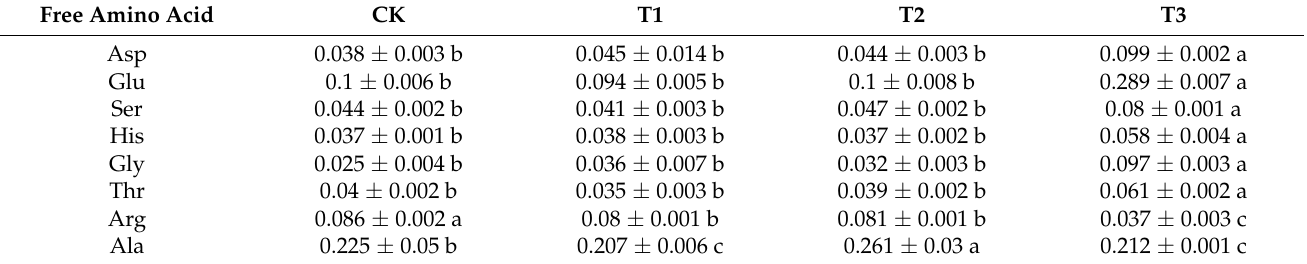
Table 3. Free amino acid content (%) in grape berries at harvest under different training systems. All parameters are performed with their standard deviation ( n = 3). For each parameter, with the same column, different letters indicate significant differences between treatments by Tukey HSD ( p ≤